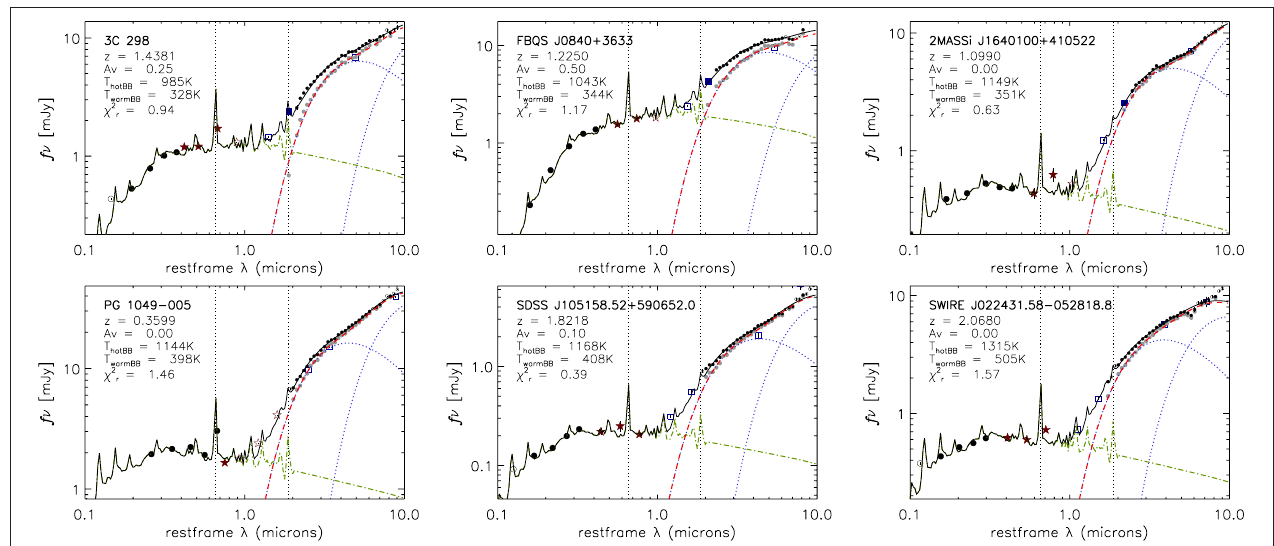
FIGURE 1 | Spectral energy distributions and their best fitting disk+dust models for a representative subsample of the luminous quasar sample showing a range of A V and dust-to-disk luminosity ratios. Circles, stars, and squares represent, respectively, broadband photometry in the observed-frame optical (from SDSS), NIR (2MASS/UKIDSS/VHS), and MIR (WISE). Open symbols indicate bands outside the wavelength range used to fit the disk or dust components. The disk model is shown as a green dot-dashed line. The (AKARI+)IRS spectrum resampled at 1λ / λ = 0.05 is shown with small black dots. Gray dots below the (AKARI+)IRS spectrum represent the dust spectrum obtained after subtraction of the disk component. The model for the AGN-heated dust emission (red dashed line) is the linear combination of two black-bodies at adjustable temperatures (blue dotted lines). The combined disk+dust model is represented by the solid black line. The vertical dotted lines indicate the rest-frame wavelength of the recombination lines H α and Pa α